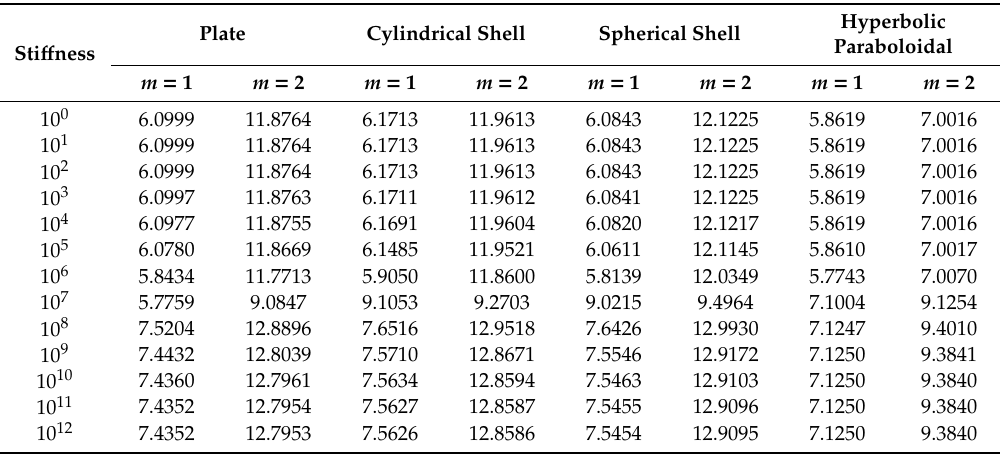
Table 16. The frequency parameter Ω for composite shallow [0 ◦ / 90 ◦ ] shells with S- K φ y boundary conditions by